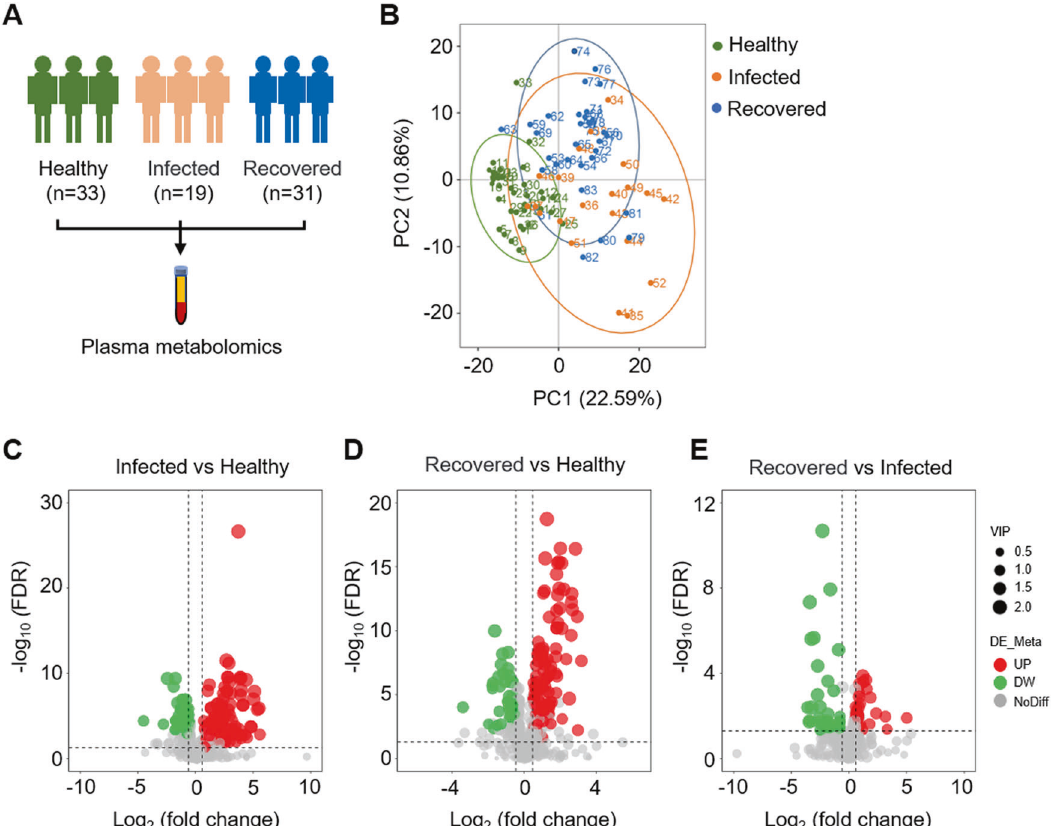
Fig. 1 Overview of the study design. A Schematic summary of study design and participants. B PCA diagram of metabolomic data from plasma samples. Each dot represents a plasma sample, and different colors mark different groups. The green, orange, and blue data points were the healthy control group, the infected group, and the recovered group, respectively. C – E Displays volcano plots comparing three pairs of groups. Each point in the volcano plots represents a metabolite. The metabolites with FDR < 0.05 were considered to be signi fi cant differences. Red represents the upregulated metabolites; green represents the downregulated metabolites. The size of the dot represents the VIP value. Cell Death and Disease (2023)